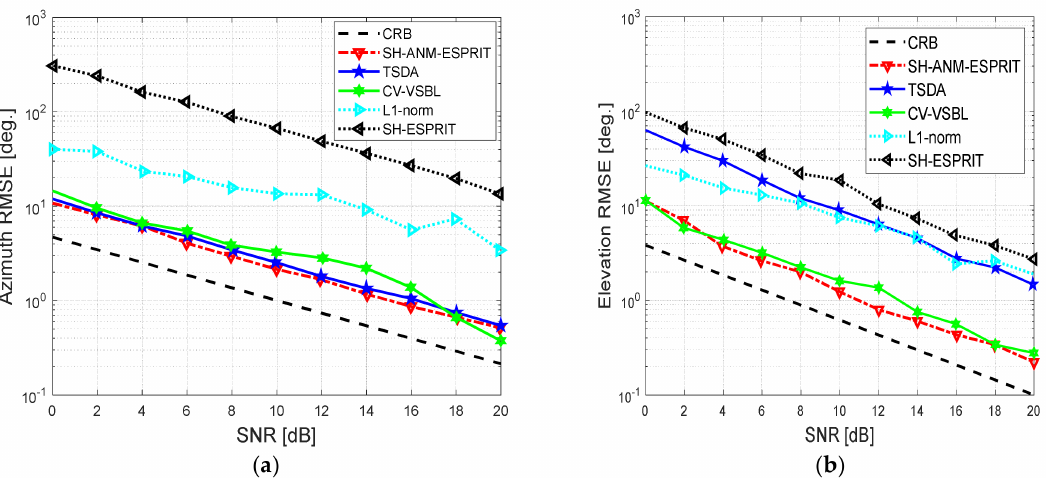
Figure 3. Comparison of performance at various SNRs under uncorrelated sources at ( θ , ϕ ) = ( 30 ◦ ,60 ◦ ) and ( 40 ◦ ,130 ◦ ) . SNR is from 0 dB to 20 dB, 250 snapshots. ( a ) Azimuth. ( b )